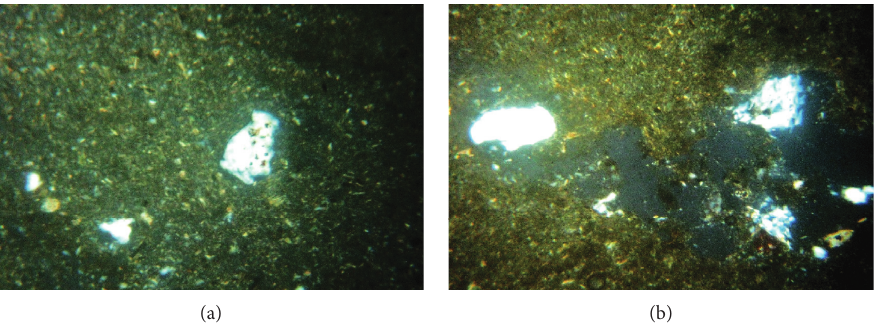
Figure 9: The anisotropy of soft clay at Site 7 (Kien Giang province) by microscopic observation: (a) vertical direction; (b) horizontal